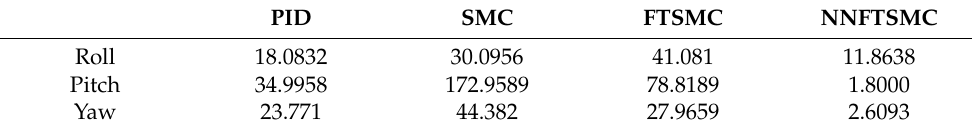
Table 4. The comparison of the simulation of attitude locking tracking results of IAE.